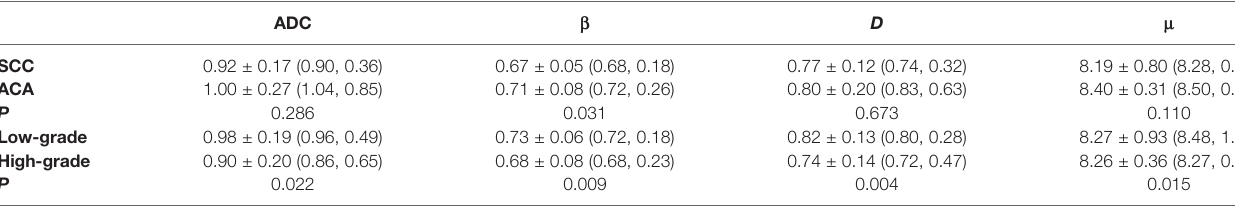
Values are given as mean ± SD (median, range). b is unitless; ADC and D with unit (×10 − 3 mm 2 /s); m with unit ( m m). P-values are statistical comparisons between different tumor subtypes and histological grades. ADC, apparent diffusion coef fi cient; FROC, fractional order calculus; SCC, cervical squamous cell carcinoma; ACA, cervical adenocarcinoma.